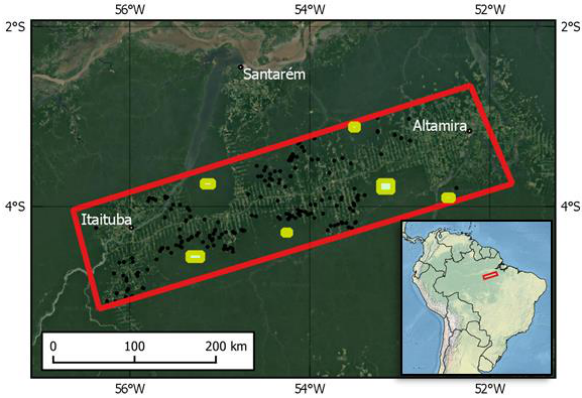
Figure 1. Study area (red), located along the Transamazonian Highway (BR-230), between the cities of Altamira and Itaituba, on the Brazilian state of Pará. Background image: Google Inc. The AOI belongs to a tropical region, characterized a wet season from November to May, followed by a drier (but not completely dry) season, from June to October. Total precipitation in Altamira varies around 1800 mm/yr. Regarding vegetation, dense ombrophylous forest covers all the intact vegetation areas. Flooded forests are not practically not present in the studied area.